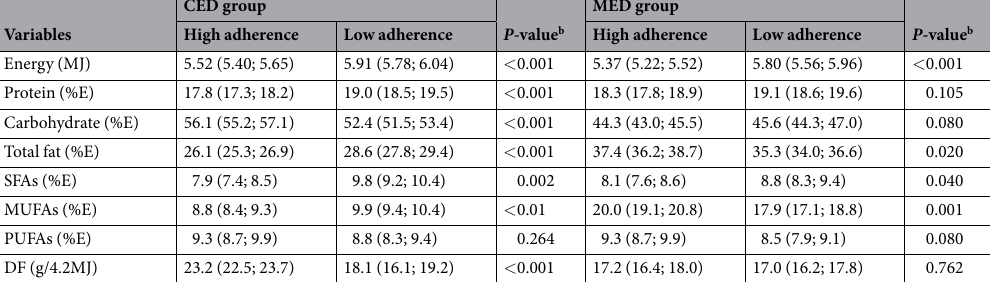
Table 5. Average energy and macronutrient intakes across median adherence in both diets a . Abbreviations: a Values are expressed as means (95% CI); SFAs: saturated fatty acid; MUFAs: monounsaturated fatty acids; PUFAs: polyunsaturated fatty acids; DF: dietary fiber; b comparison of between-group (high vs. low adherence) changes (from baseline to average across the four postrandomization time points); High adherence here means adherence scores above a median value, with low adherence referring to adherence scores below that median value.